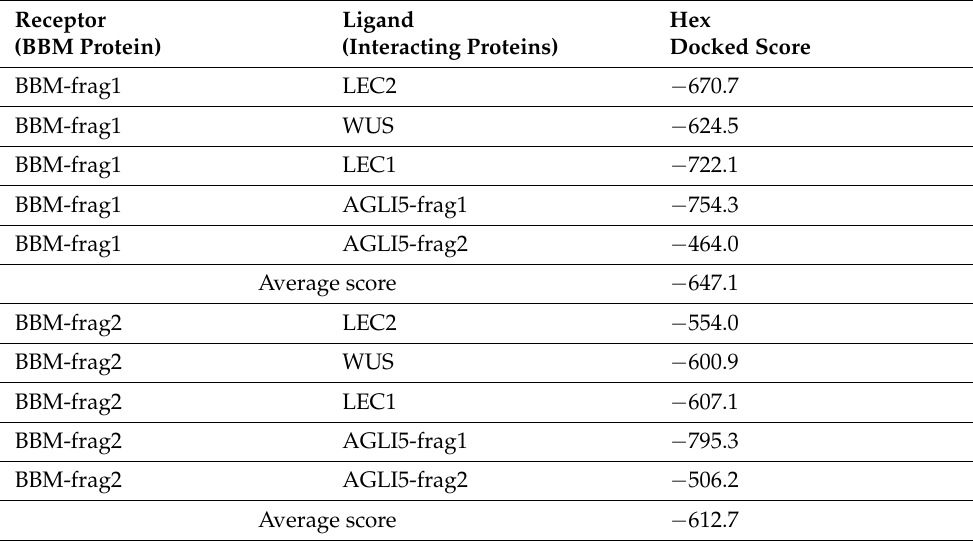
Figure 4. BBM PPI. ( a ) Predicted interactions from STRING. ( b ) Predicted interactions from BioGRID. Table 2. Docked score of BBM fragments with its interacting partners using Hex